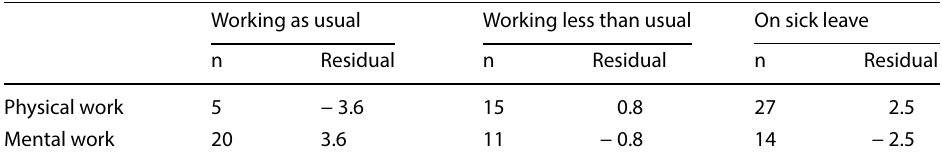
N = 92. Residual = Adjusted